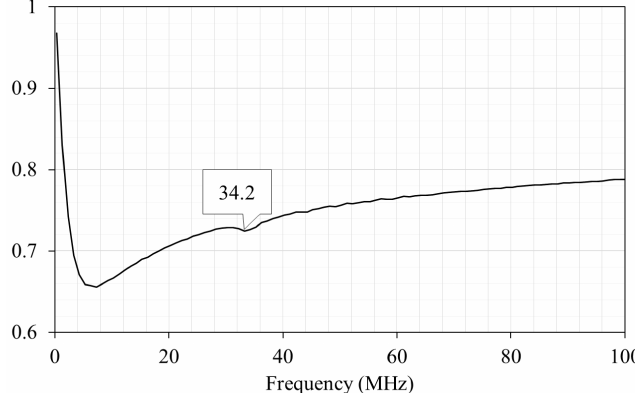
Figure 3. Vector Network Analyzer ( VNA) curve of the S coefficient) measured for the 28 μm thickness PVDF transducer without electric